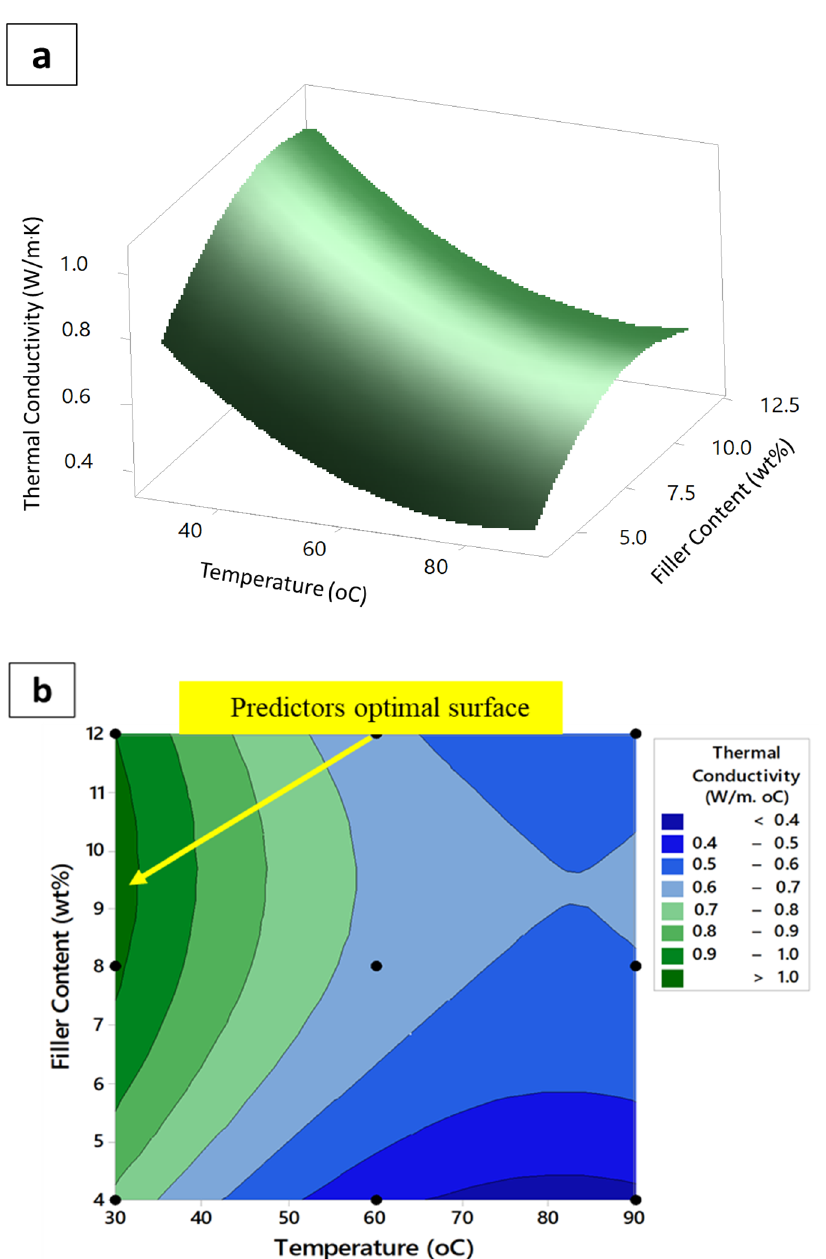
Figure 7. ( a ) Surface and ( b ) contour plots for the thermal conductivity of the nanocomposites vs. magnetic filler content and